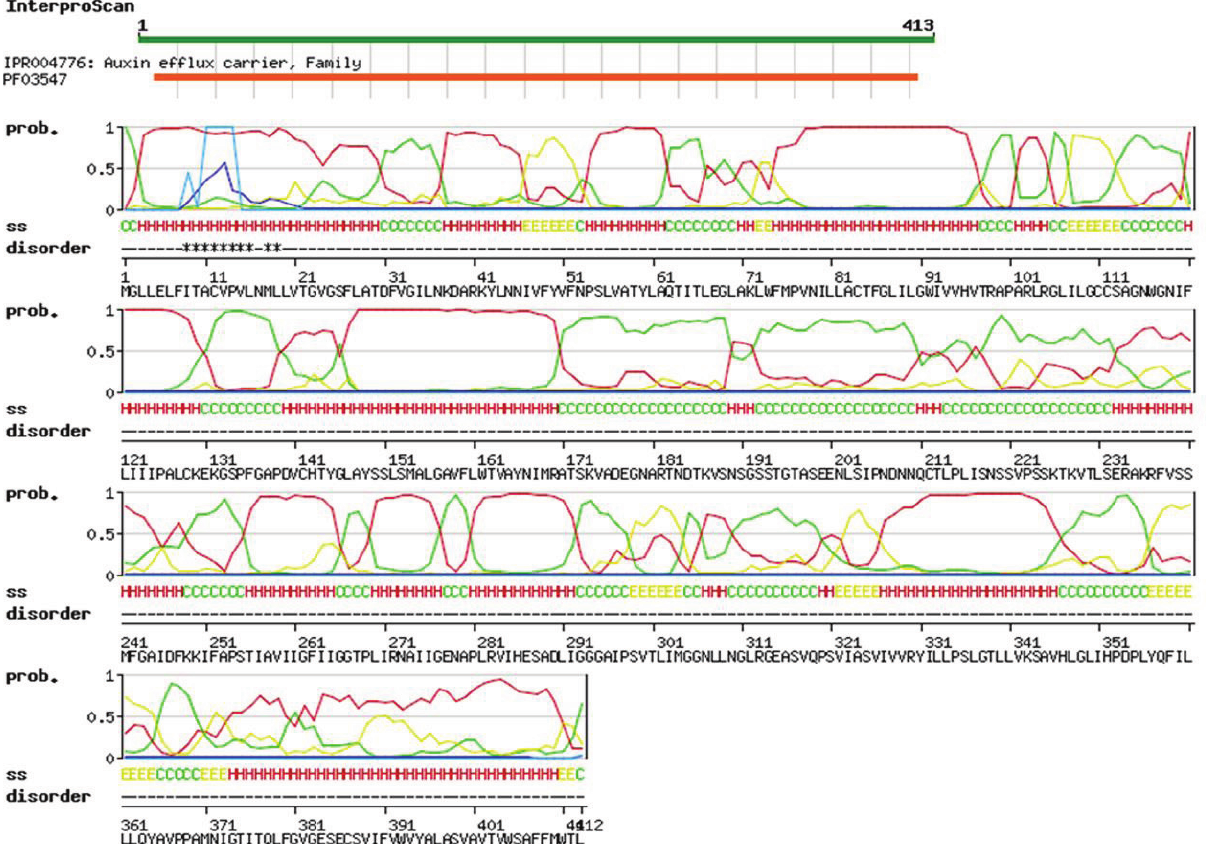
Figure 3. Auxin efflux carrier domain of the OsPILS gene. The Swiss workspace model (http://swissmodel.expasy.org/workspace/) was used to predict the auxin efflux carrier domain of OsPILS genes. All OsPILS genes contain auxin efflux carrier